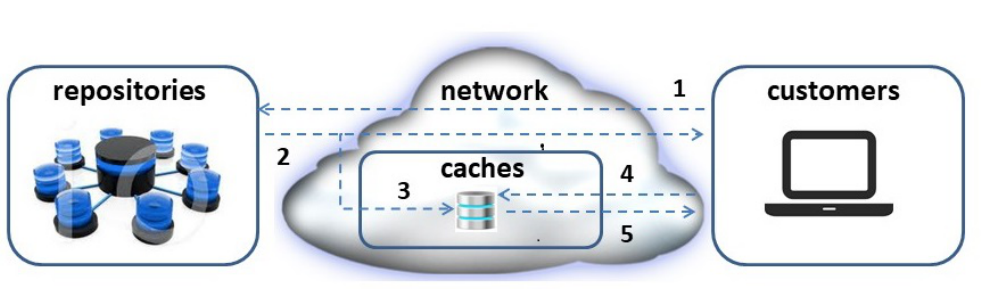
Figure 1. Reference model for network